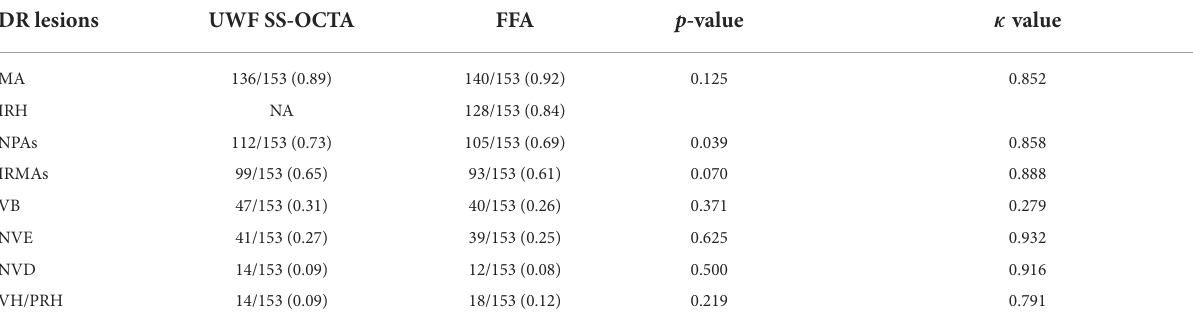
TABLE 2 Detection rate of DR lesions on UWF SS-OCTA vs.